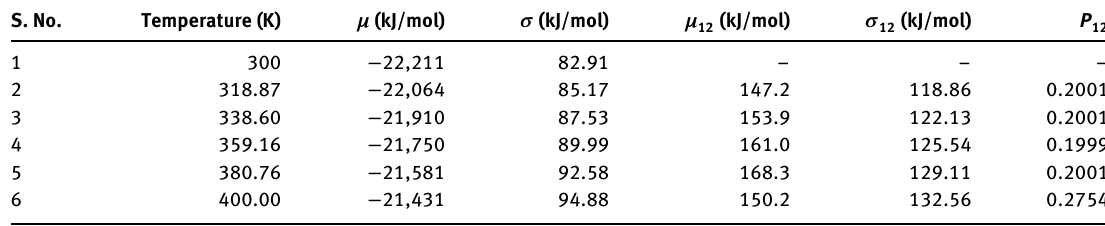
Table 5: Different temperatures, energies and probability exchange rate required for replica exchange molecular dynamic simulation (REMD) of modeled